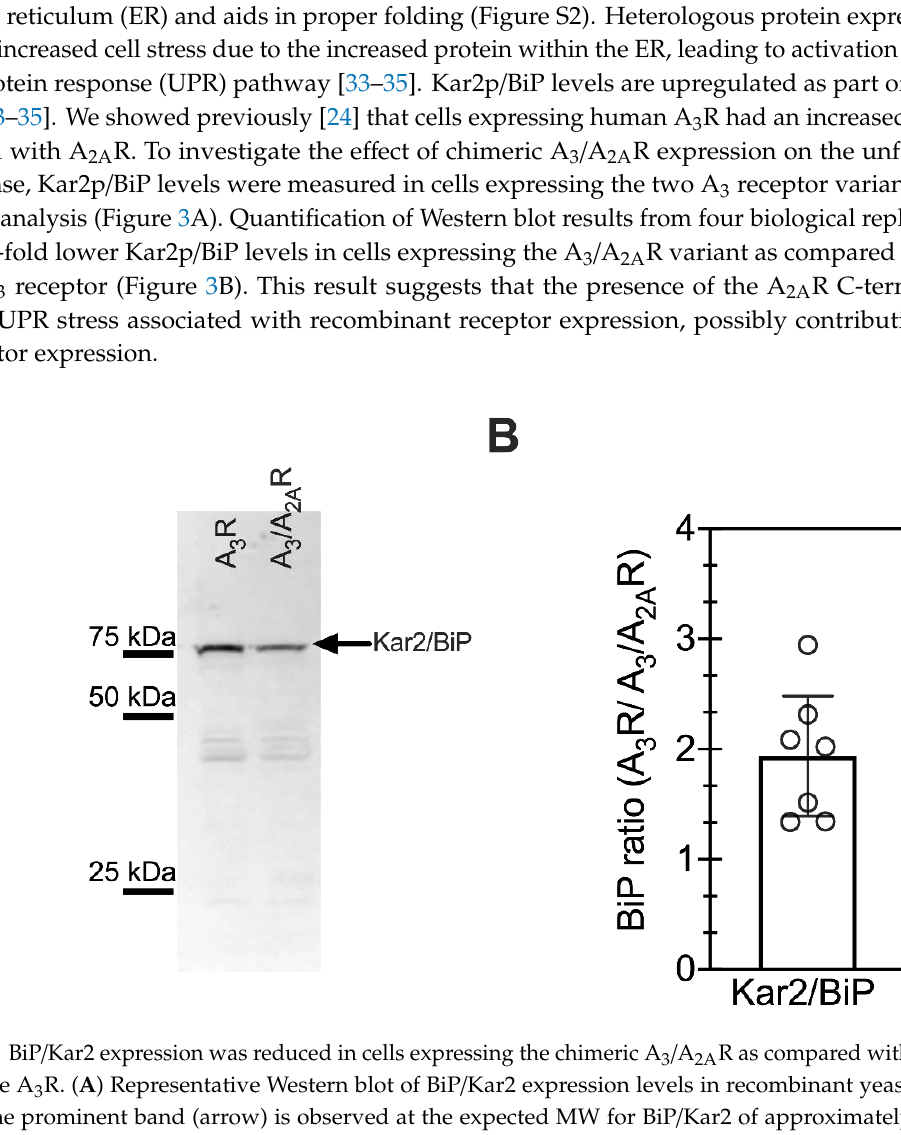
fluorescence (arbitrary units, AU) as a surrogate marker for total receptor levels. Yellow filled circles represent data for A 3 R, whereas black open circles represent A 3 /A 2A R. Data points are the average of at least 3 biological replicates; lines are a guide for the eye. Error bars represent the standard error from the average. Data points significantly different from A 3 R are indicated with * ( p -value < 0.05 using Student’s t -test).